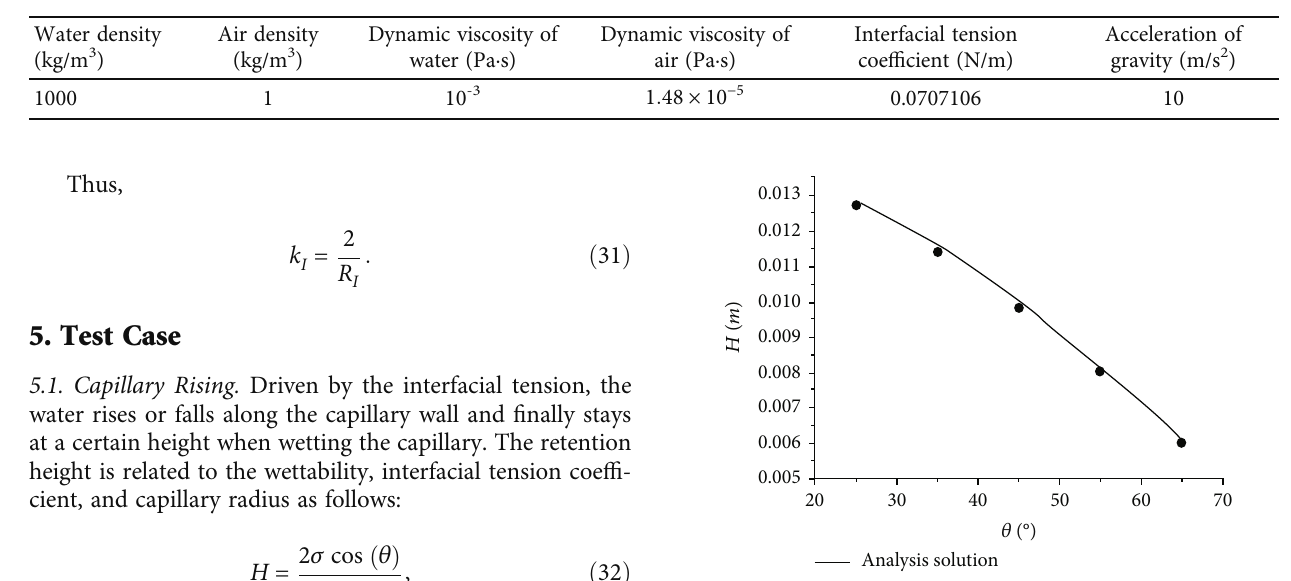
Table 1: Physical parameters used in the simulation of capillary